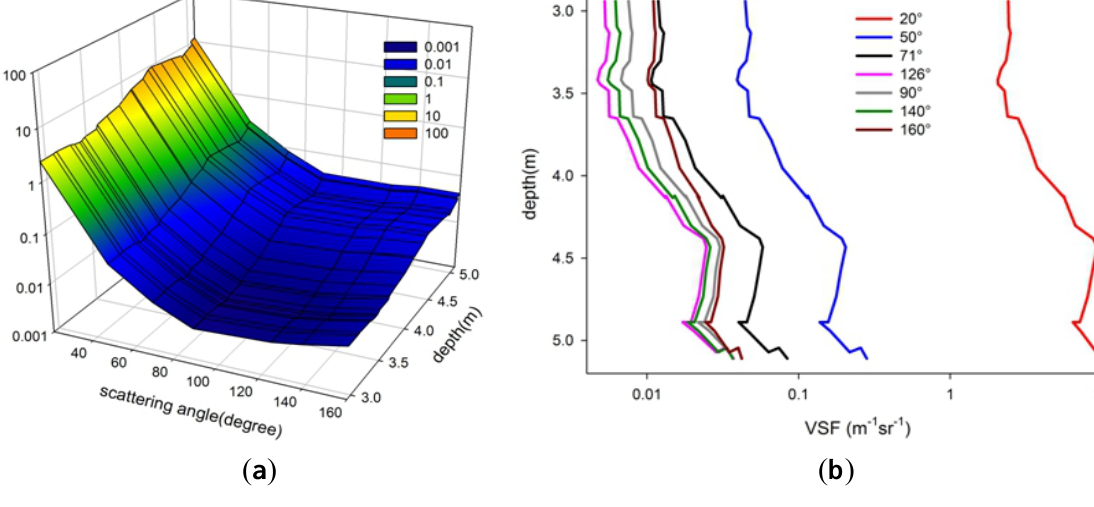
Table 1. The relative error δ ( ψ ) and the average error δ